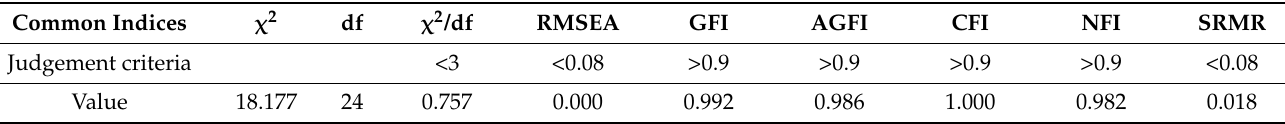
Table 10. Adaptability of second-order CFA model.